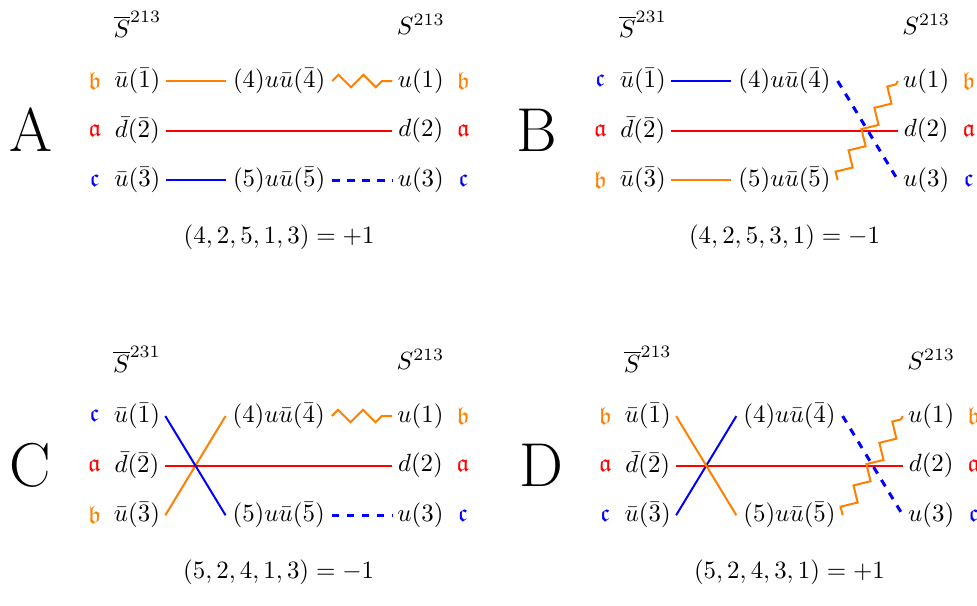
Figure 32 . The same as figure 31, but for the contributions to O uu ( C 1 ,uuuu